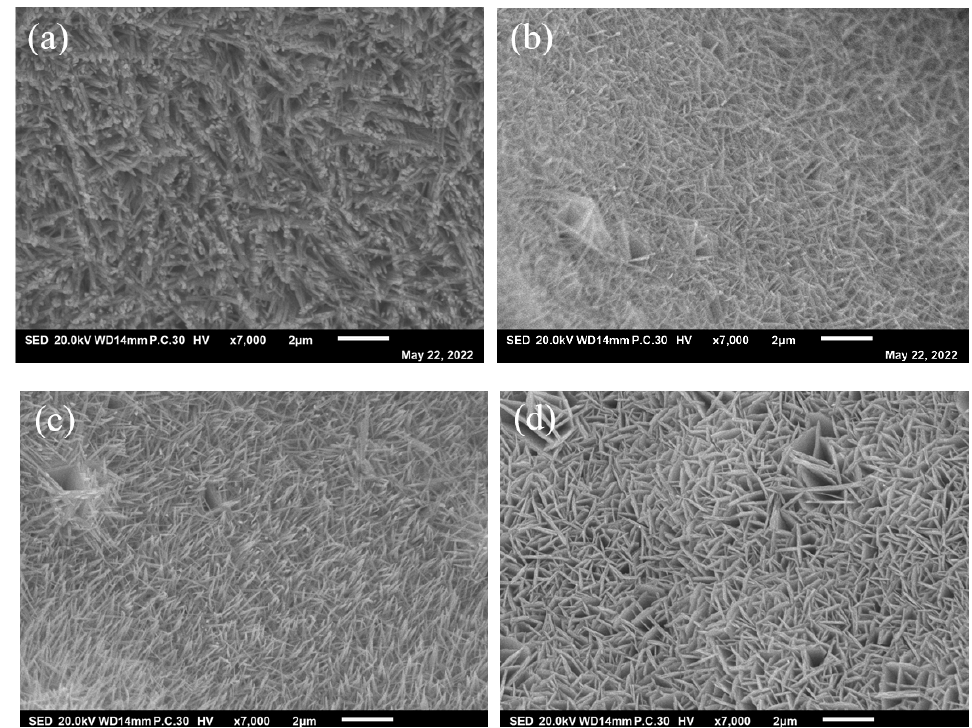
Figure 2. Low magnification of ( a ) NiCo-LDH/NF, ( b ) Ni 4 Co 4 Fe-LDH/NF, ( c ) Ni 4 Co 4 Fe 2 -LDH/NF, and ( d ) Ni 4 Co 4 Fe 3 -LDH/NF nanoarrays.